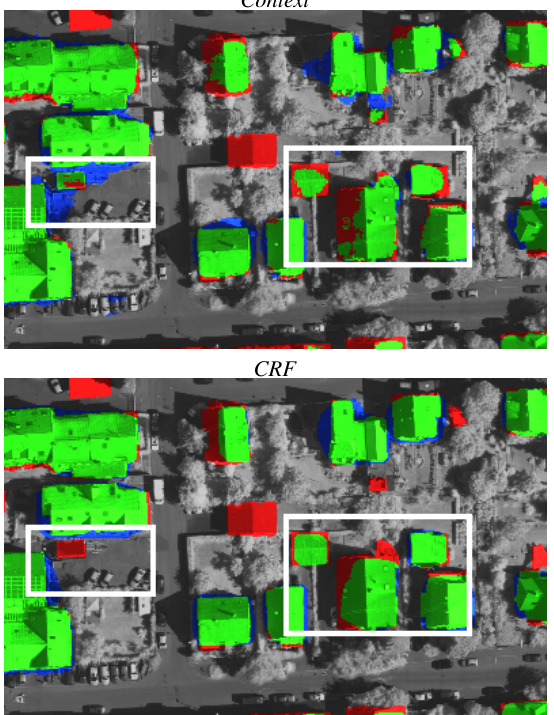
Figure 5. Example of extracted buildings. True positives are dis- played green, false positives blue, and false negatives red. White frames highlight significant differences/improvements.